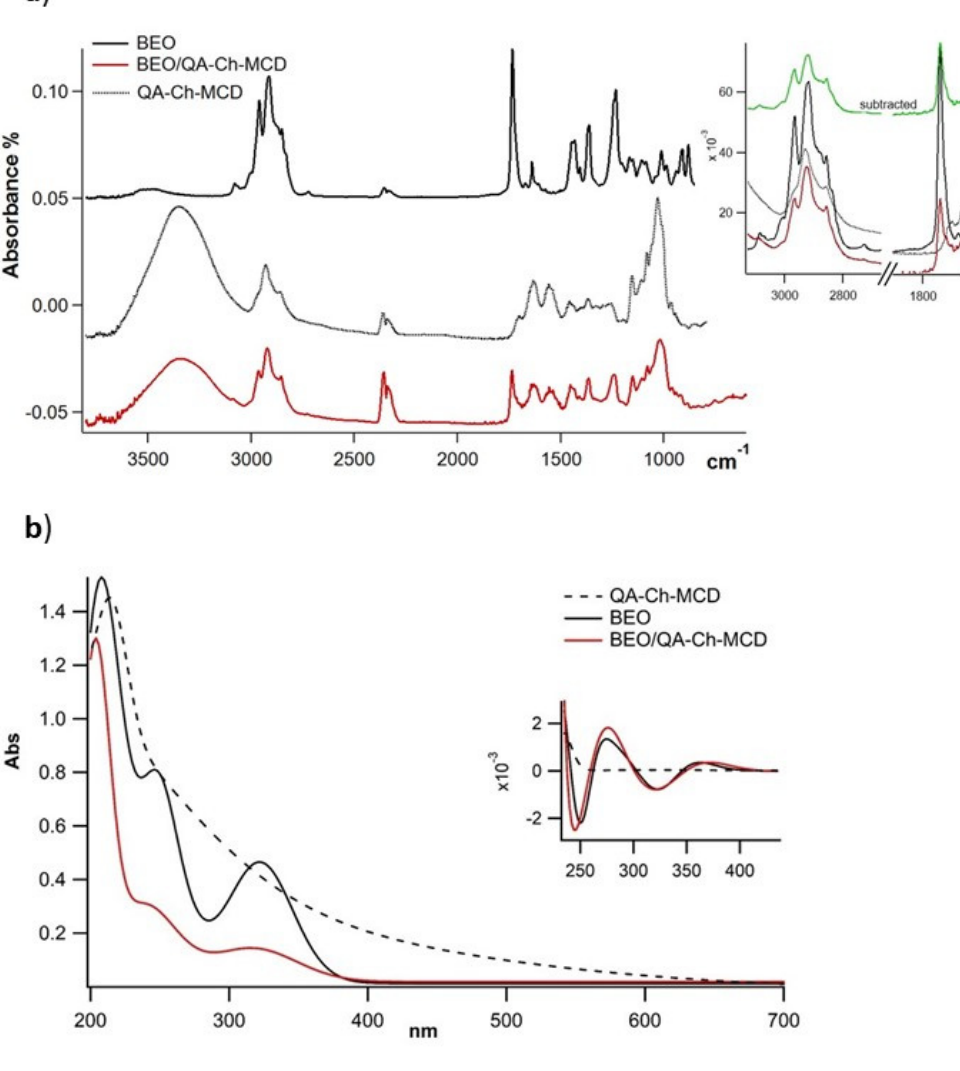
Figure 1. Spectroscopic characterization of BEO (black), BEO/QA-Ch-MCD (red), QA-Ch-MCD (dashed line). ( a ) ATR-FTIR full spectra, and in the box are the overlays of C-H (3000–2800 cm − 1 ) and C=O (1700 cm − 1 ) stretching bands, the green line represents the spectrum obtained by subtracting QA-Ch-MCD from the BEO/QA-MCD spectrum and evidencing the shift of the 2918 cm − 1 band. ( b ) UV-Vis full spectra, and in the box are the second derivative profiles evidencing the shift of the 250 nm band.